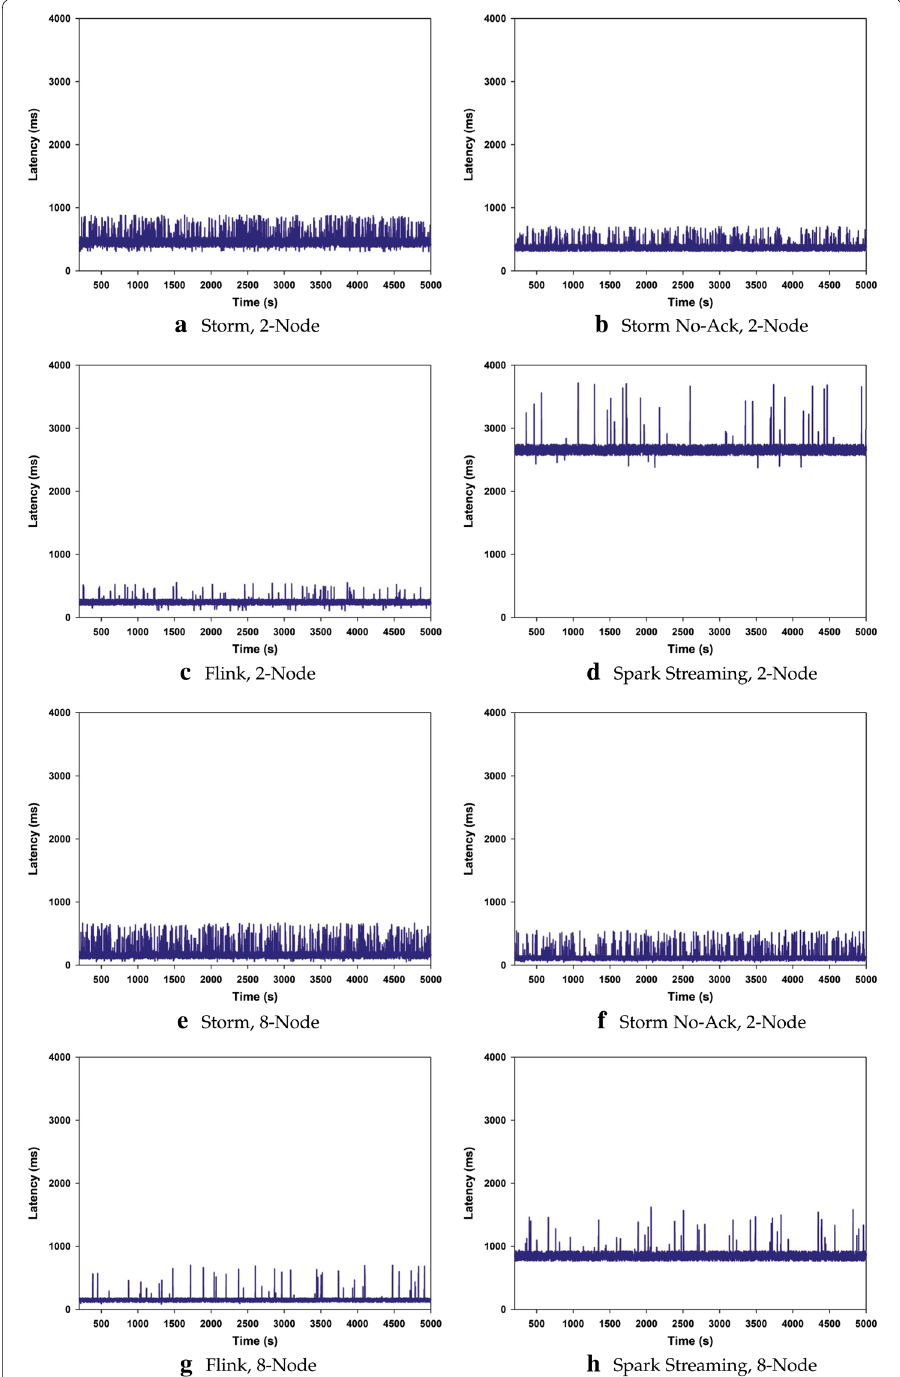
Fig. 11 Latency of intended frameworks with different number of worker nodes for Advertising